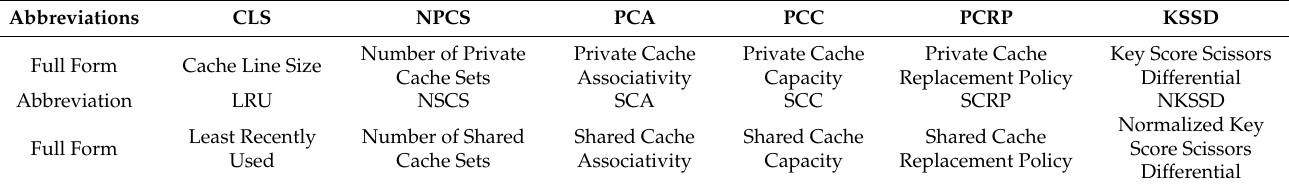
Table 1. List of frequently used